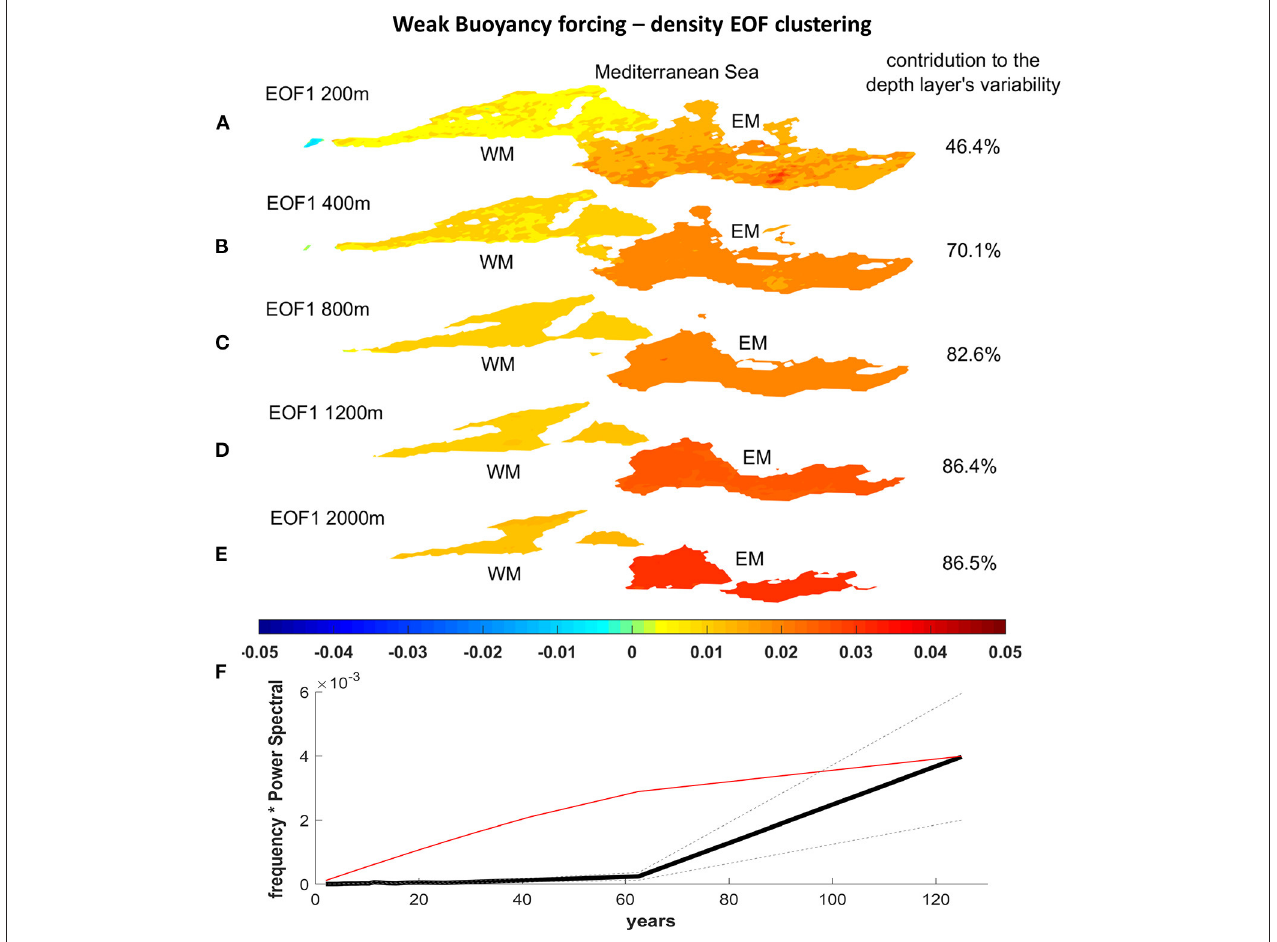
FIGURE 13 | The first EOF modes from 200 to 2,000m depth (A–E) of the WBF experiment, whose expansion coefficients are well-correlated. Here, the variance-preserving spectrum of the 2,000m first EOF is presented as (F)